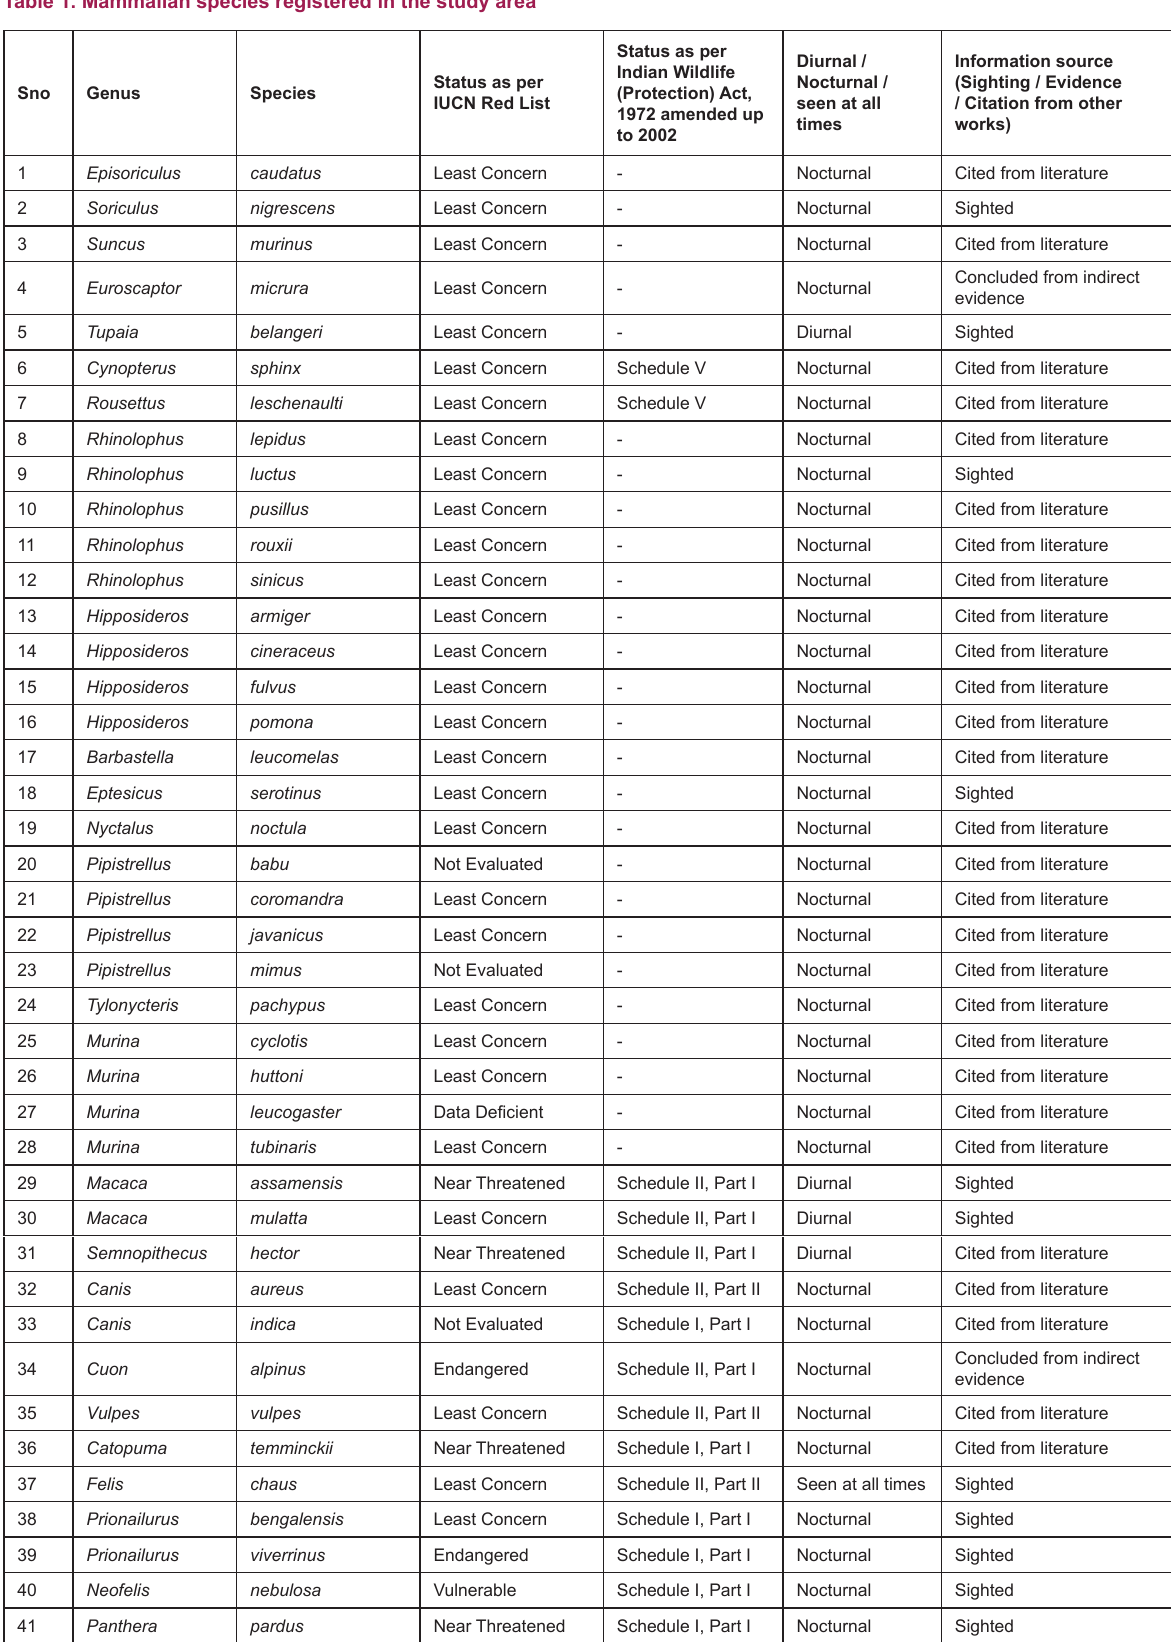
Table 1. Mammalian species registered in the study